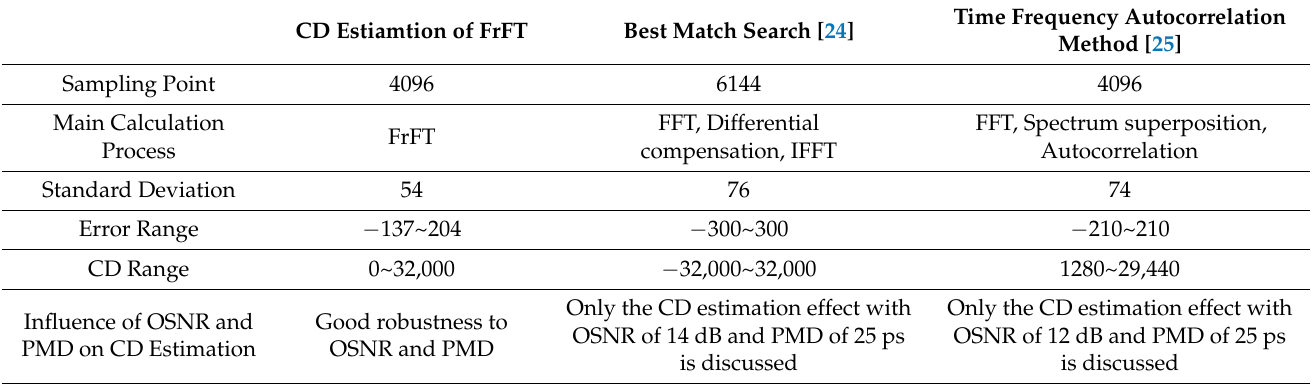
Table 4. CD estimation performance under different sampling points and search